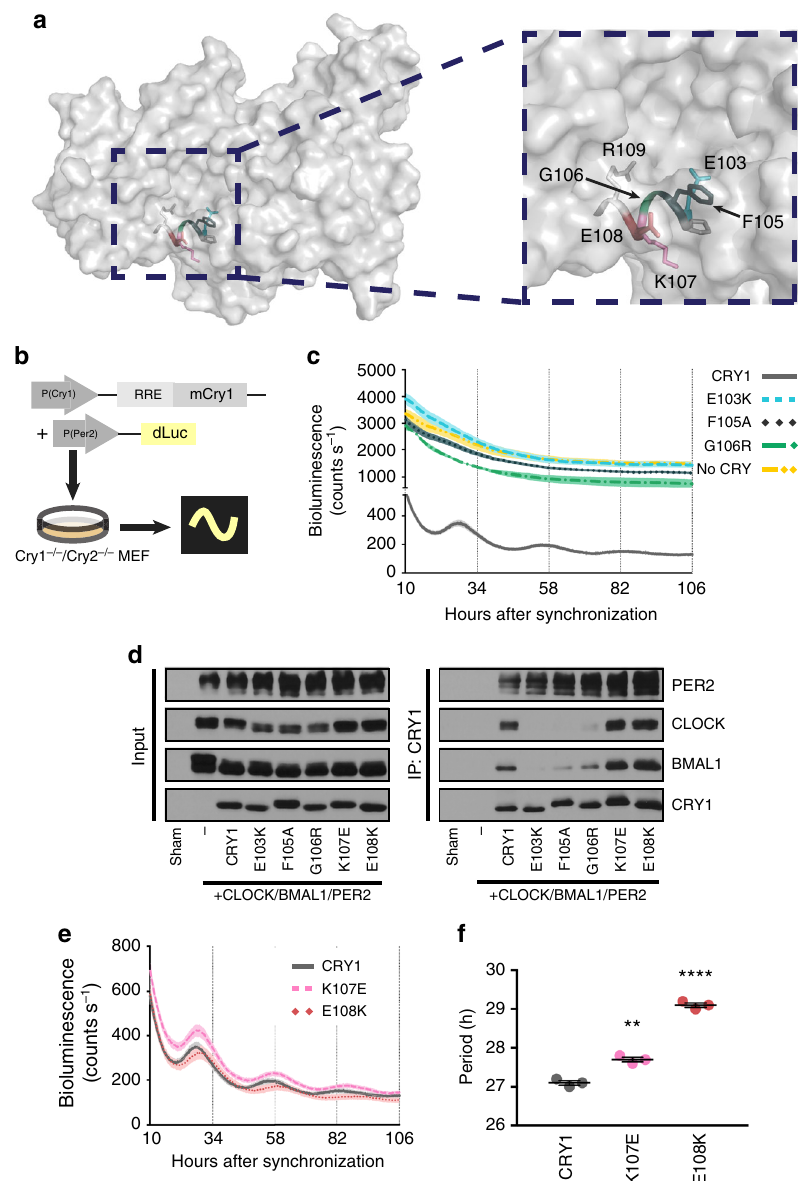
Fig. 3 The lower helical boundary of CRY ’ s secondary pocket gates interaction with CLOCK. a A surface view of the structure of CRY1 (PDB: 5T5X) with the lower helix of the secondary pocket shown as a ribbon diagram with side chains shown as sticks and relevant residues color-coded for the rest of the fi gure. Inset is a magni fi ed view of this helix with residues labeled. b Schematic of Cry1 rescue assay. RRE is an ROR response element necessary for delayed expression of CRY. c Rescue assays with CRY1 mutants identi fi ed in the SCA ( n = 3 per condition, re fl ective of 6 plates from two independent experiments) shown as means ± SEM. d Co-IP assay with PER2, CLOCK, BMAL1, and various CRY1 mutants. Multiple bands in PER2, CLOCK, and BMAL1 lanes are indicative of post-translational modi fi cations on these proteins. Blot is representative of at least three independent experiments. e Rescue assays for two CRY1 residues not identi fi ed in the SCA ( n = 3 per condition, re fl ective of 6 plates from two independent experiments) shown as means ± SEM. f Period plot for the data shown in e . Asterisks show signi fi cance by unpaired t test with Welch ’ s correction (** p = 0.0018, **** p <